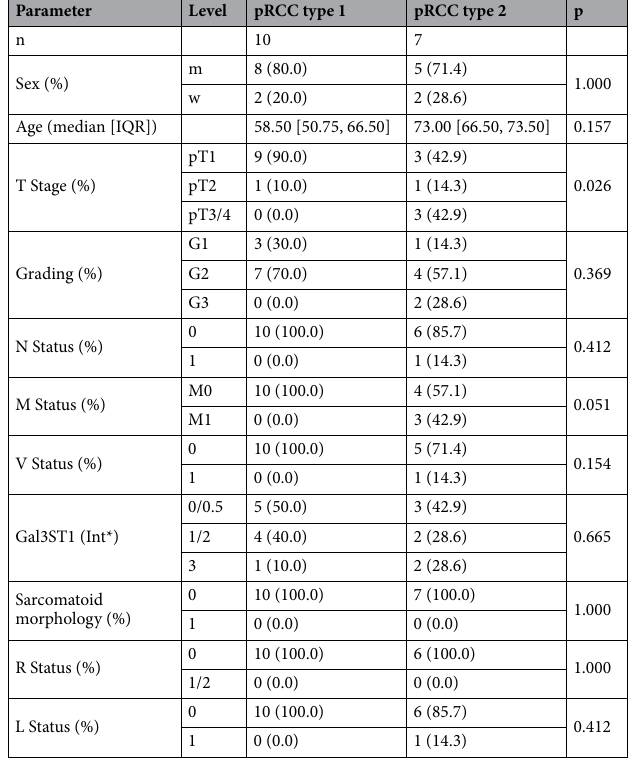
Table 5. Association of pRCC histotypes 1 and 2 with classical risk factors and Gal3ST1 expression (Fisher’s exact test). * Int Expression